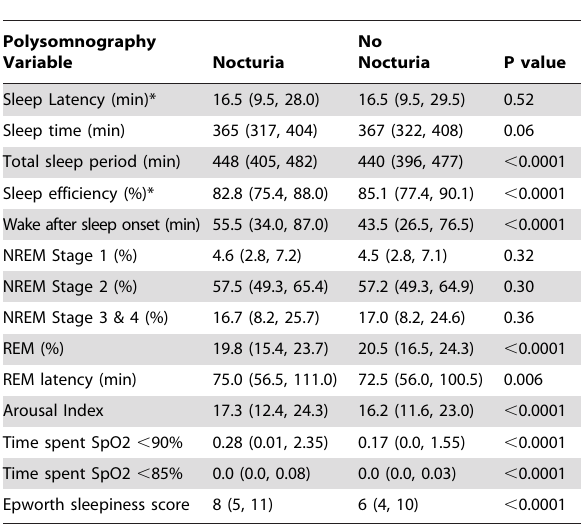
Table 6. Polysomnographic variables and subjective